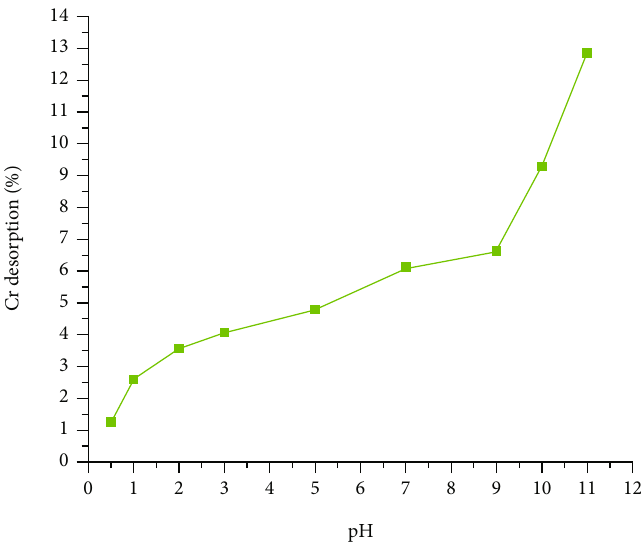
Figure 11: Cr desorption from co ff ee husk activated